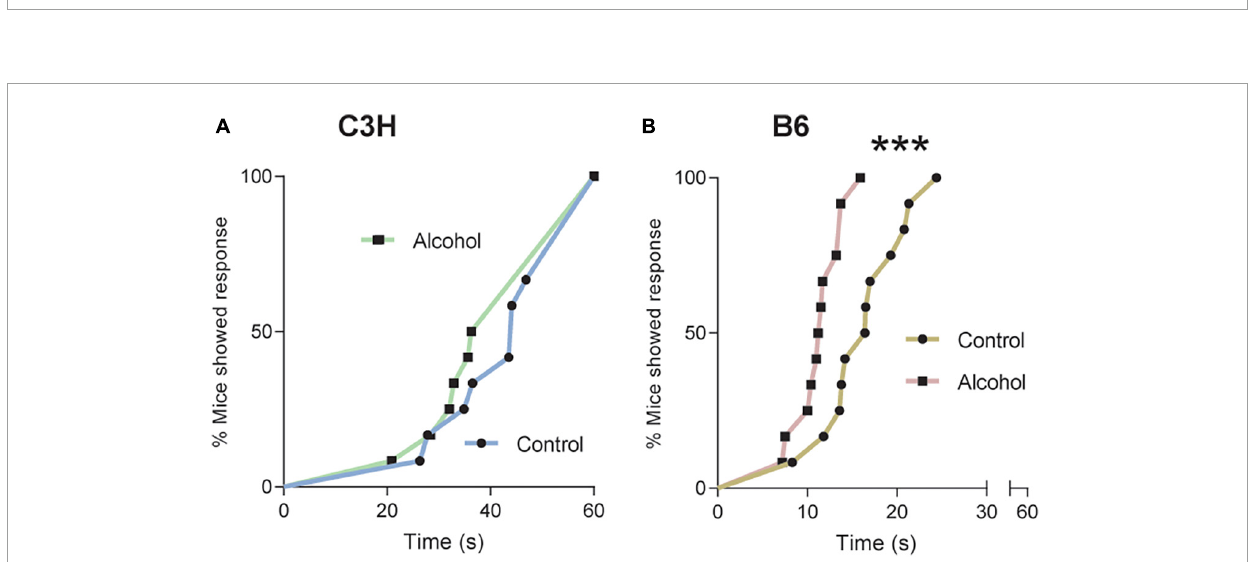
FIGURE4 Pronociceptive effects of alcohol exposure and subsequent withdrawal. Latencies in seconds to nociceptive response in C3H (A) and B6 (B) mice tested on a 52 ◦ C hot-plate at withdrawal day 1, with a cutoff at 60 s. Data are shown as the cumulative % of mice showing a response as a function of time. Multiple mice with the same latency appear as individual points. Note the truncated abscissa in panel (B) . n = 12. *** p < 0.001 represents cox proportional hazard regression, alcohol vs.